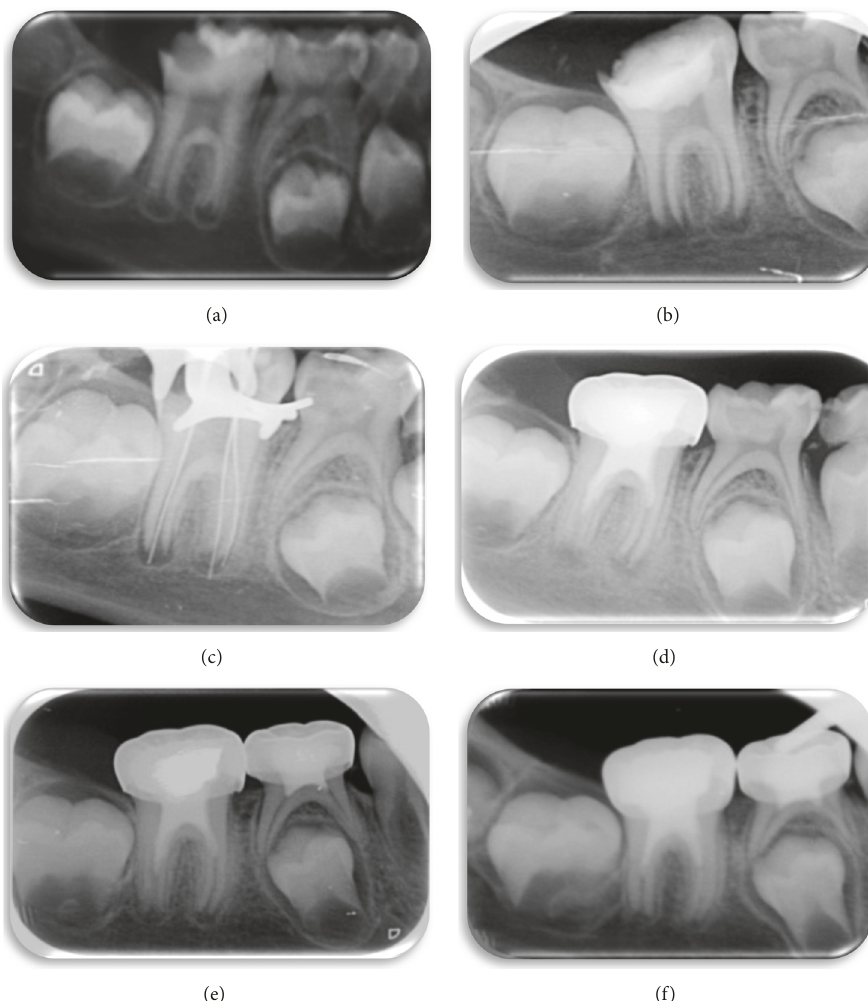
Figure 1: (a) Initial radiograph of large occlusodistal caries on tooth 36, extending to the pulp chamber and with periapical translucencies. (b) Radiograph showing triple antibiotic paste in the canal. (c) A size 15 K-file is used to irritate the apical tissue to induce bleeding. (d) Periapical radiograph of MTA over the blood clot and the pulp chamber sealed with glass ionomer, composite, and metal crown. (e) Follow-up radiograph taken 6 months after completion of treatment. By comparing this radiograph with those taken previously, the periapical radiotranslucency has decreased and there is further closure of the apical foramen. (f) Follow-up of 12 months after carrying out revascularization treatment. The periapical radiotranslucency has practically disappeared; there is further thickening of the dentinal walls and the apical foramen has almost